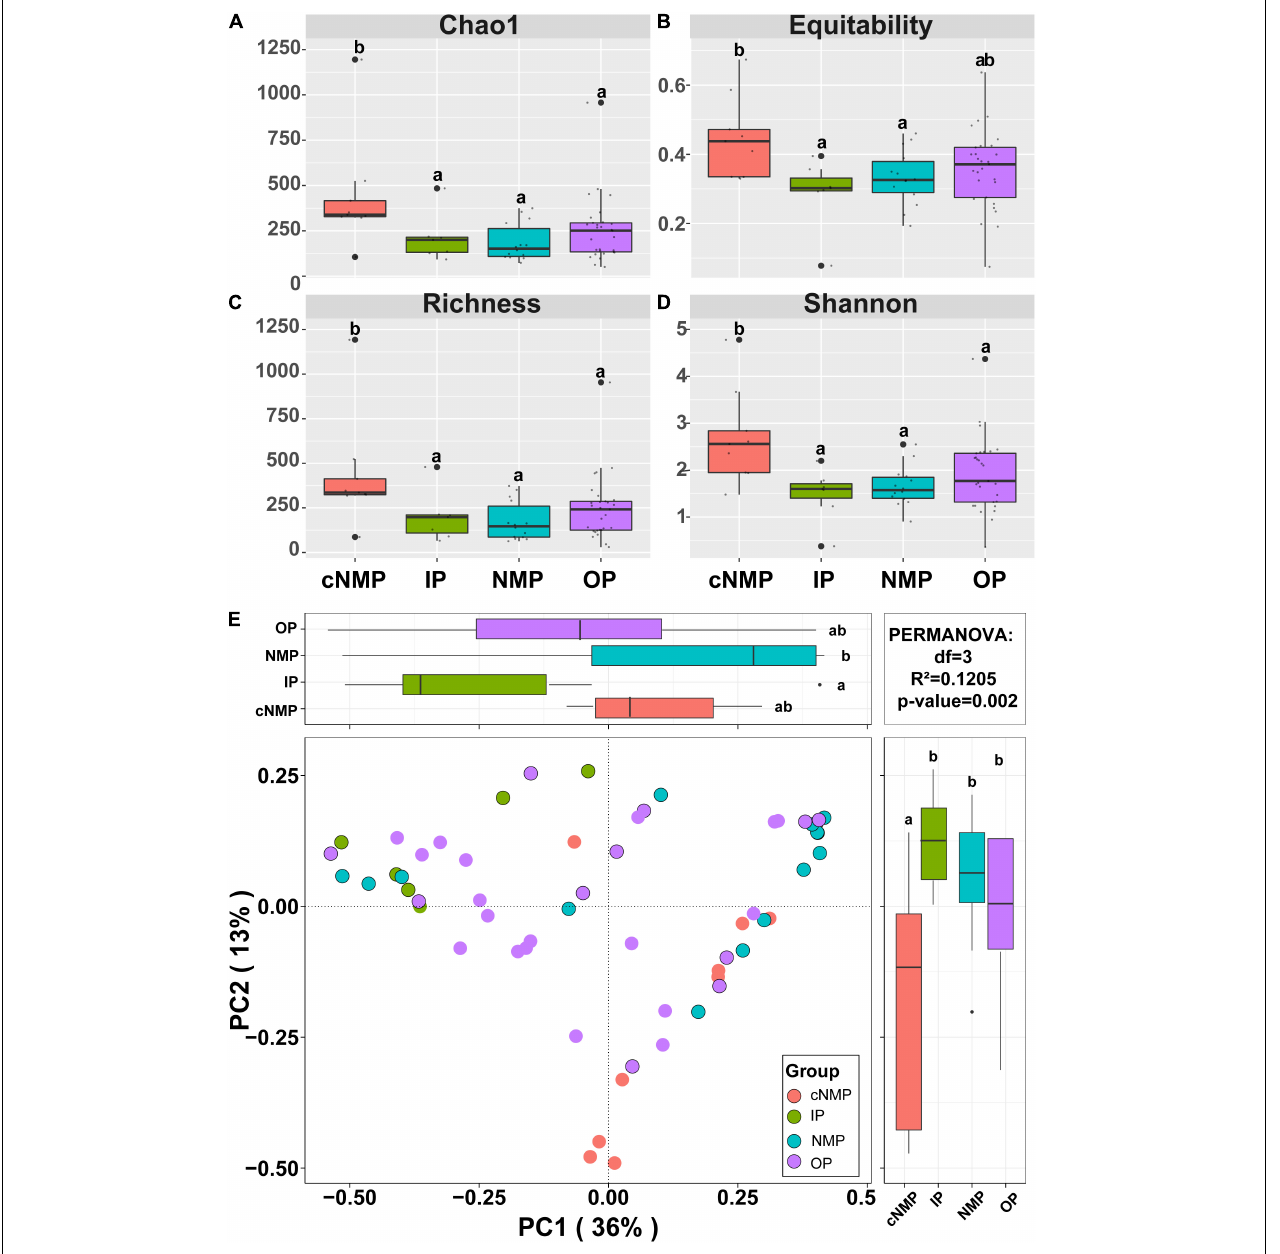
FIGURE 2 | Community species compositions and diversity of bacterial community in DPR with different phosphorus sources. Species diversity characterized by the (A) Chao1 index, (B) Equitability index, (C) Richness index, and (D) Shannon index. (E) Ordination of bacterial community compositions (at OTU level) by PCoA based on the Bray–Curtis dissimilarity matrix. Different letters indicate significant differences at the p < 0.05 level. DPR, denitrifying phosphorus removal; OTU, operational taxonomic unit; PCoA, principal coordinate